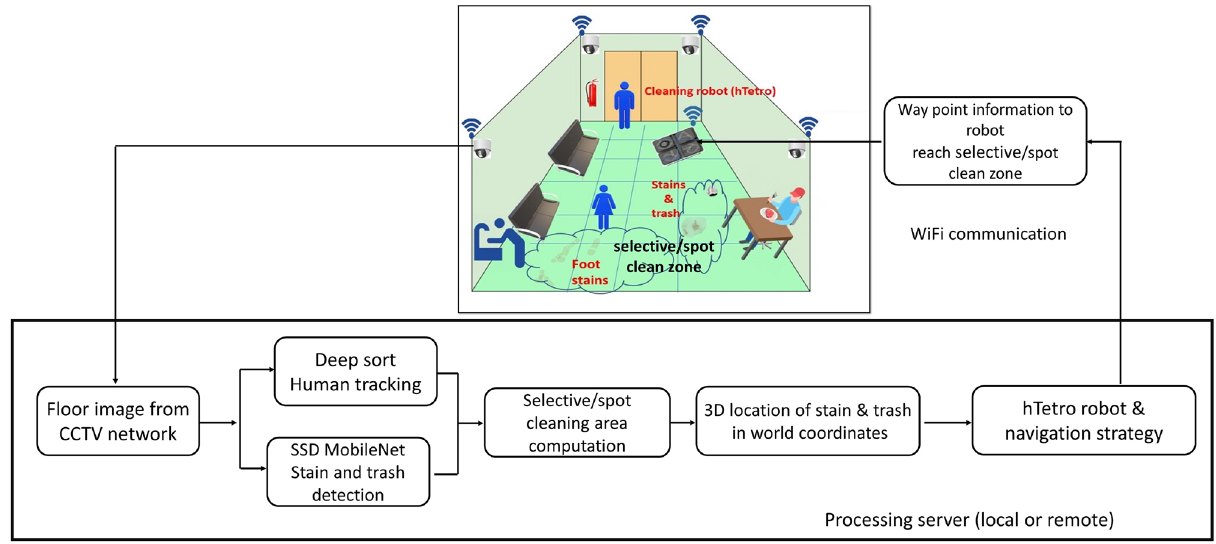
Figure 1. Overview of the proposed